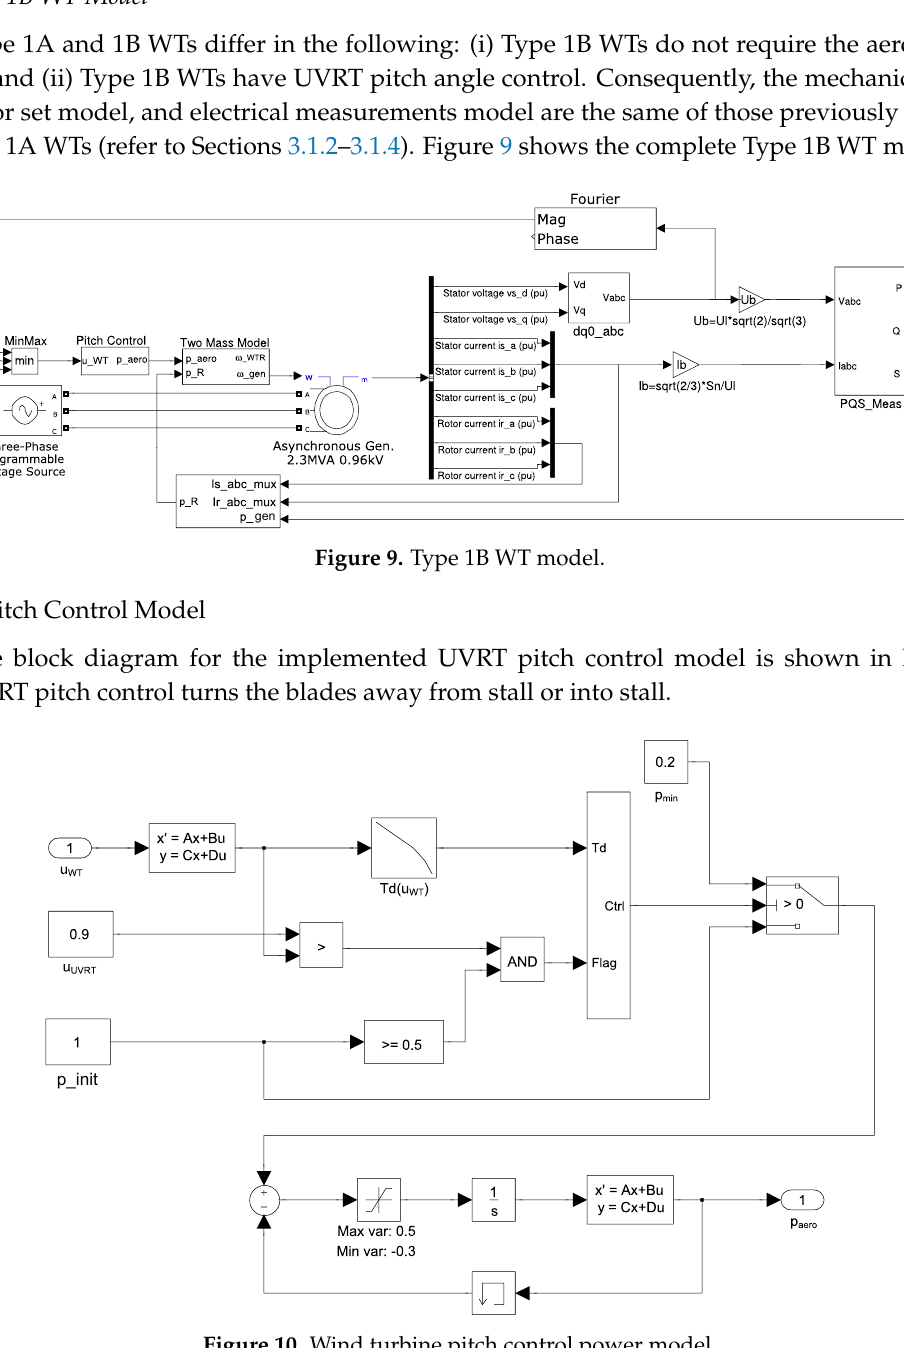
Figure 10. Wind turbine pitch control power